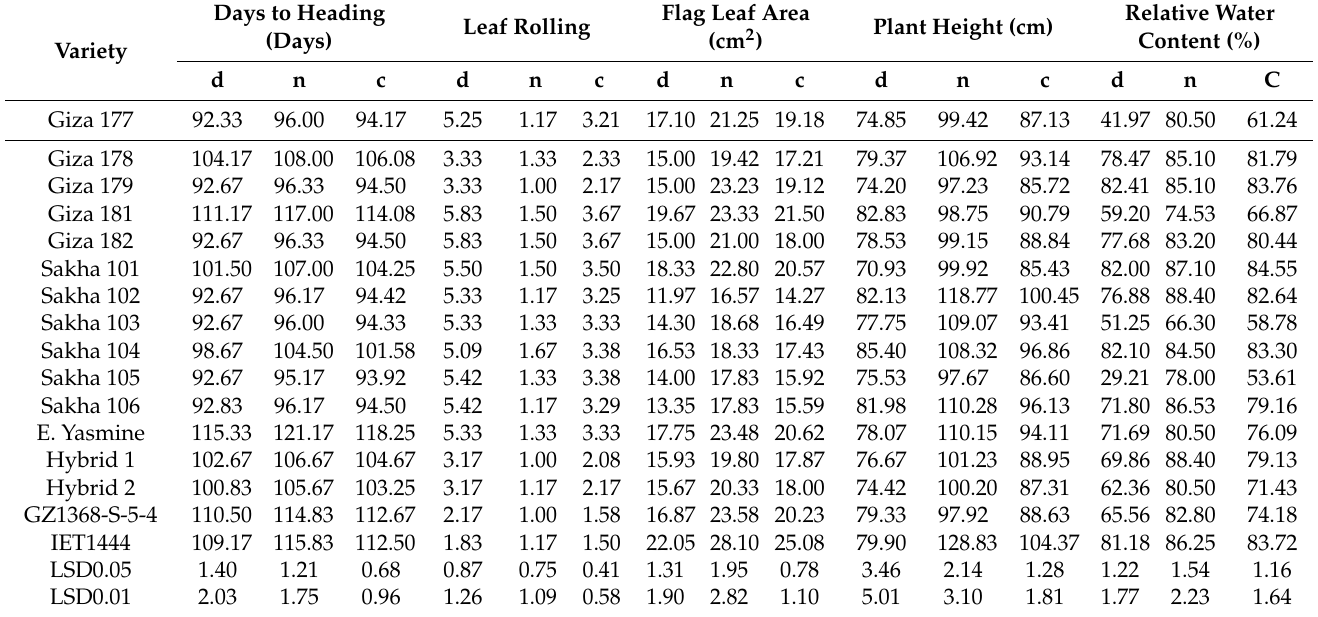
Table 7. Growth characteristics of genotype under normal, drought conditions, and their combined